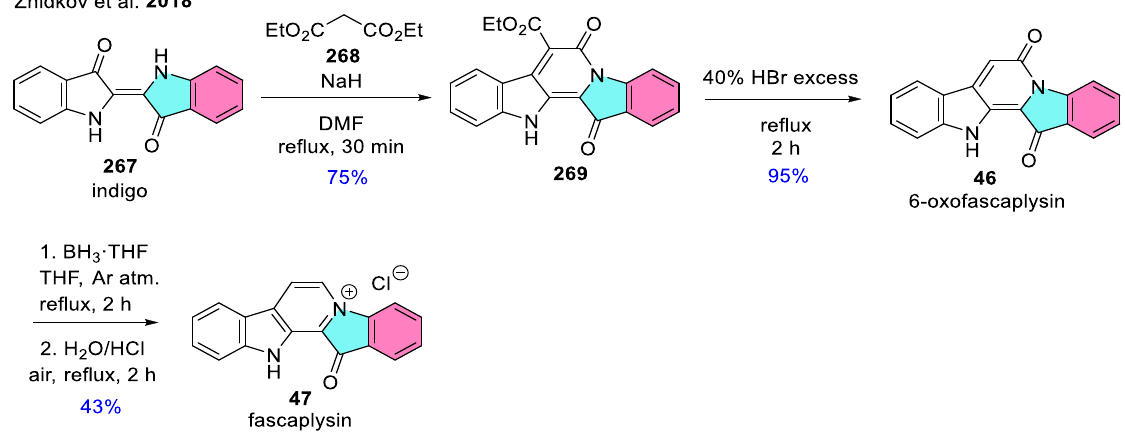
Scheme 32. First synthesis of 6-oxofascaplysin ( 46 ) and a new synthetic route for the preparation of fascaplysin ( 47